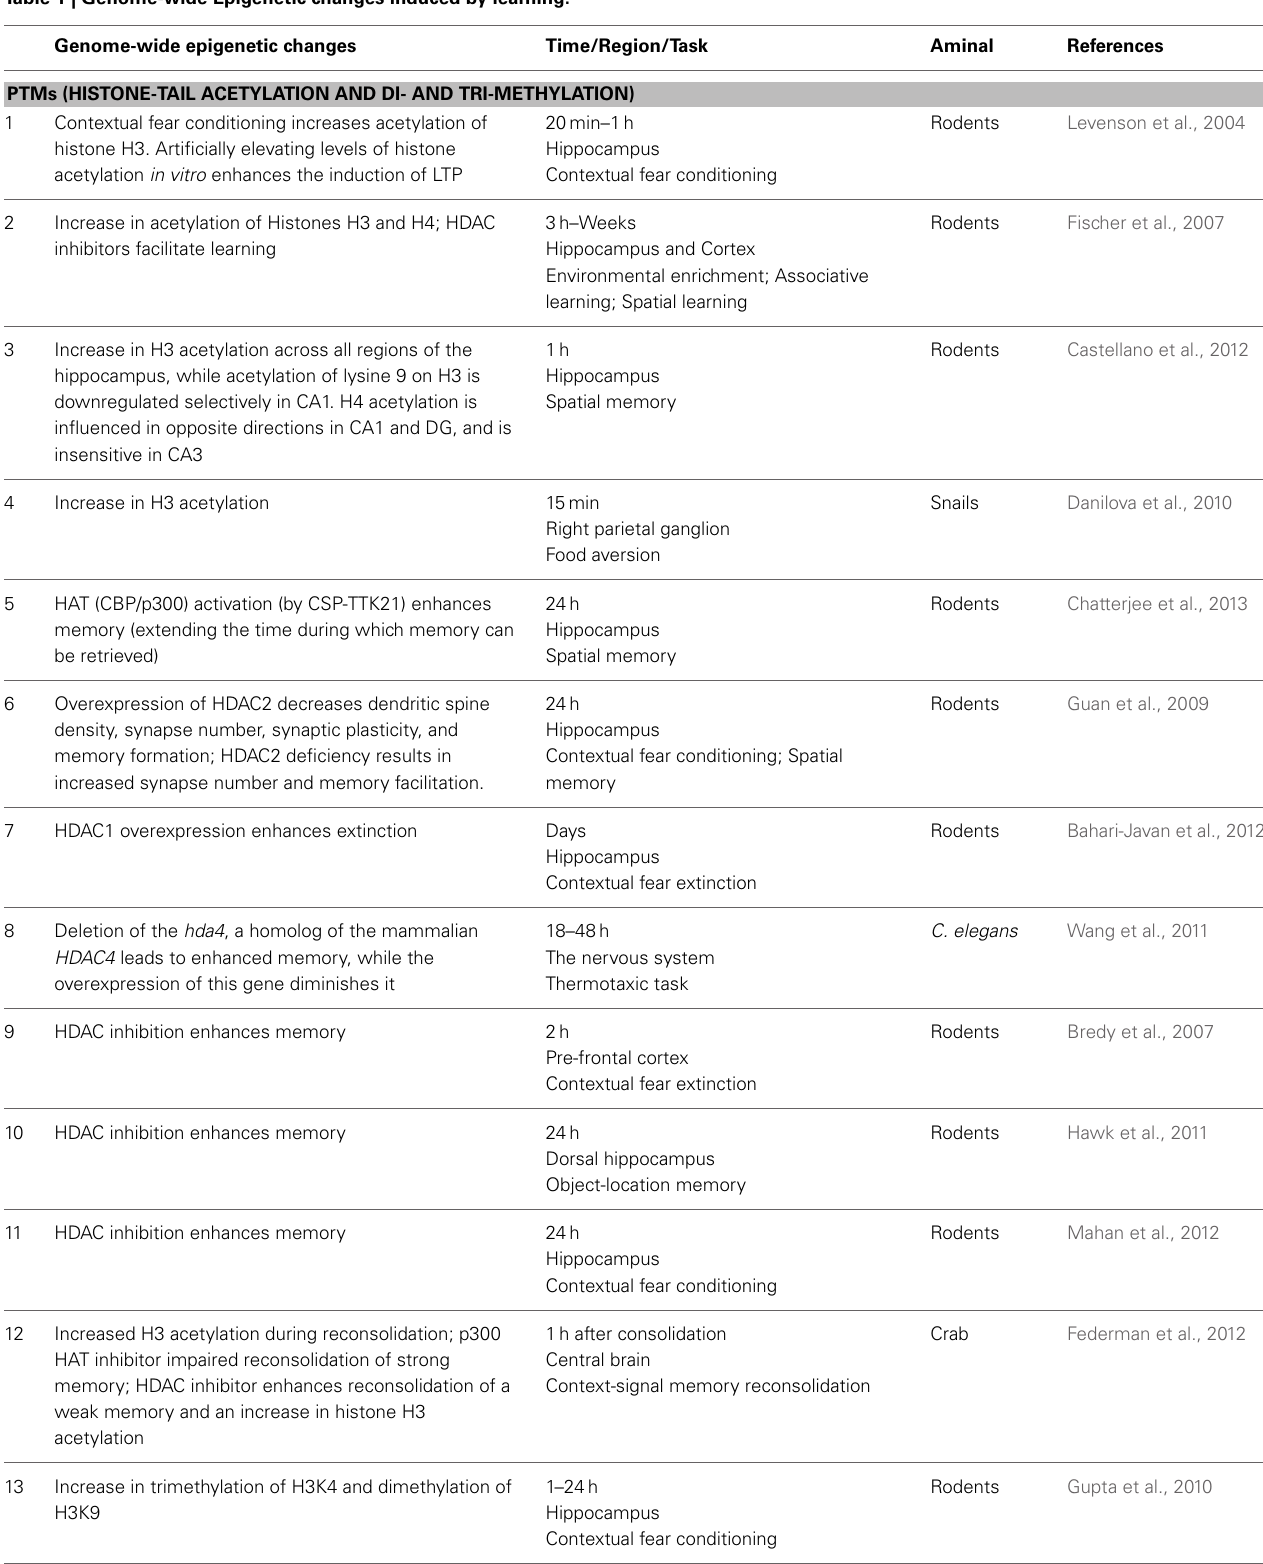
Table 1 | Genome-wide Epigenetic changes induced by learning. Genome-wide epigenetic